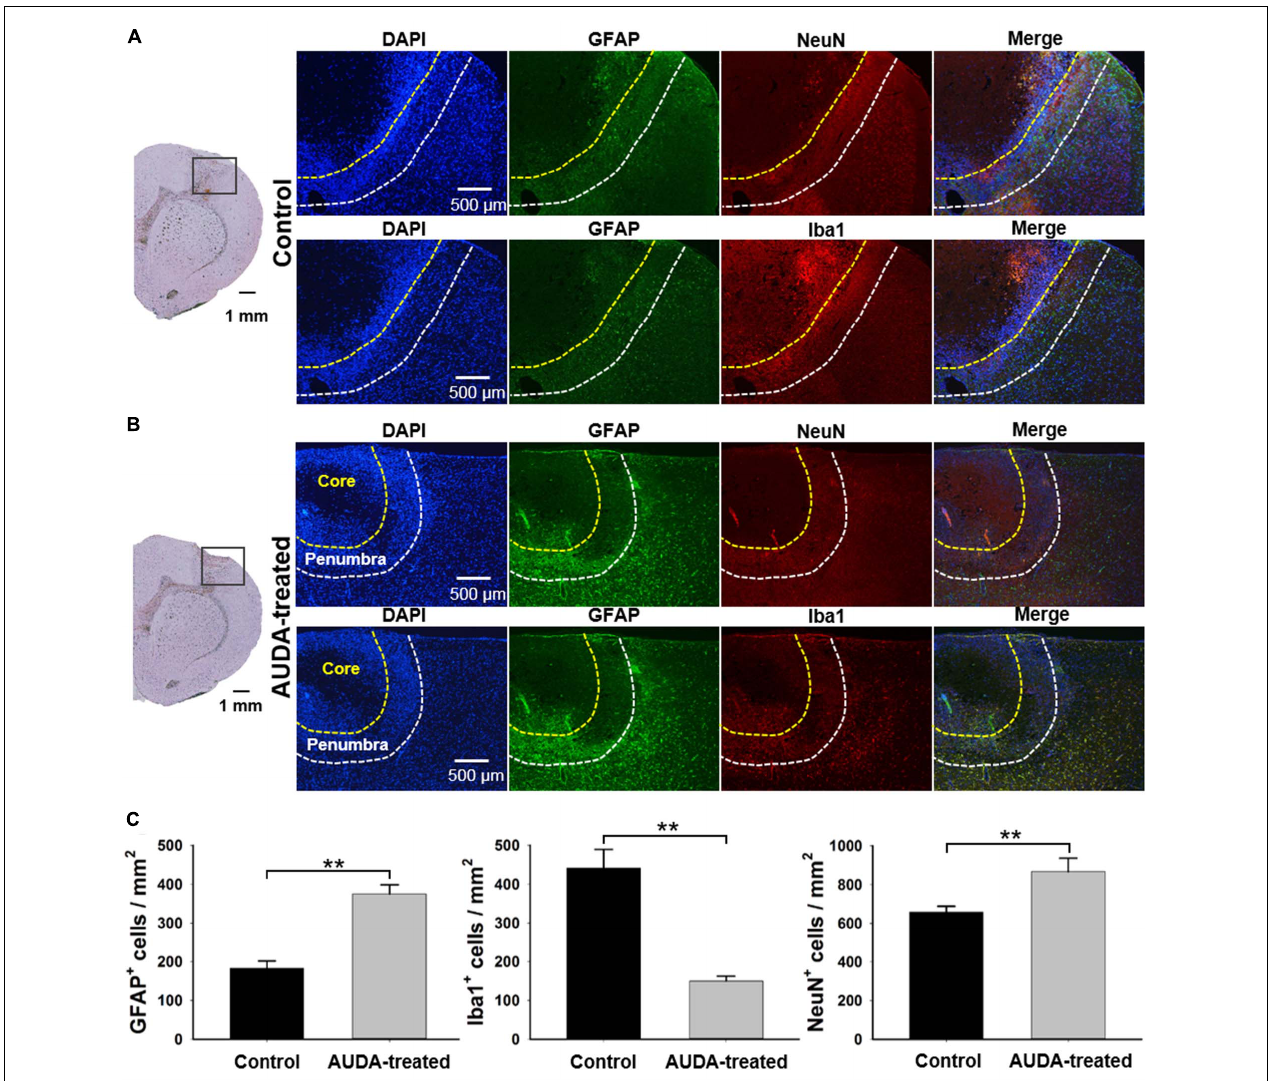
FIGURE 7 | Comparison of NeuN + , GFAP + , and Iba1 + cell expression in ischemic core and penumbra at 7 days following PTI stroke. Representative images show double immunofluorescence staining of DAPI (blue), GFAP (green), NeuN (red), and Iba1 (red) in coronal sections under normal conditions at 7 days following PTI stroke. The observed region was selected within the boundary of the injury area under the bright field of the brain section, as shown in the left panel in the control group (A) and the AUDA-treated group (B) . The area of the ischemic core and penumbra are indicated by yellow dotted line and white dotted line, respectively, as established according to the expression intensity of NeuN + cells. The 2 rows in a group represented 2 adjacent brain sections, containing all 4 markers. (C) The comparison of cell counts of NeuN + , GFAP + , and Iba1 + cells in the ischemic penumbra region in both groups. The density of GFAP + cells and NeuN + cells in the AUDA-treated group was significantly higher than that in the control group in the penumbra region. The number of Iba1 + cells in the AUDA-treated group was significantly lower than that in the control group in the penumbra region. The scale bar represents 500 µ m in immunofluorescence images and represents 1 mm in the bright field of the brain sections. The symbol “ ∗∗ ” indicates significant differences (** p < 0.01, Mann–Whitney U -test). Data are presented as the mean ± SEM. N = 5 for each